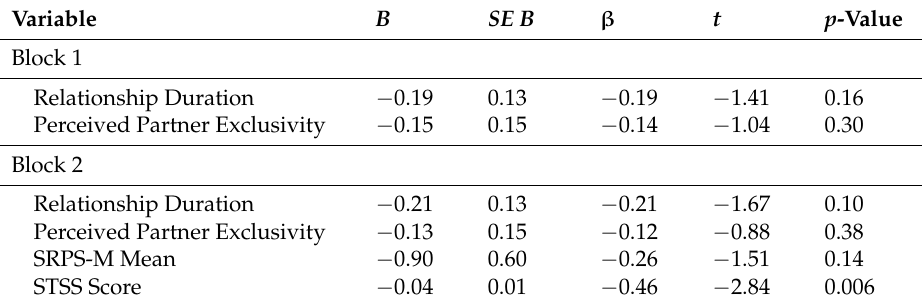
Table 4. Hierarchical Regression Analysis for Variables Predicting Condom Use Frequency.